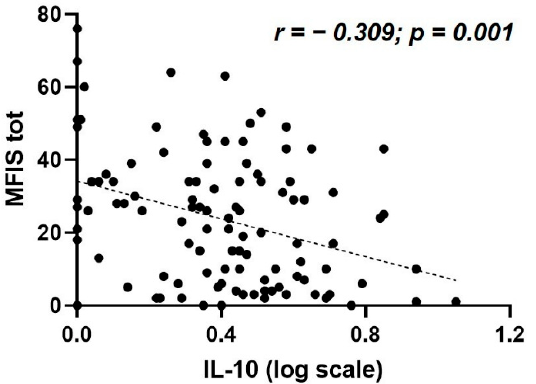
Figure 1. Correlation between MFIS total score and CSF IL-10 levels at MS diagnosis. Abbreviations: CSF, cerebrospinal fluid; IL, interleukin; MFIS tot, Modified Fatigue Impact Scale total score; MS, multiple sclerosis.